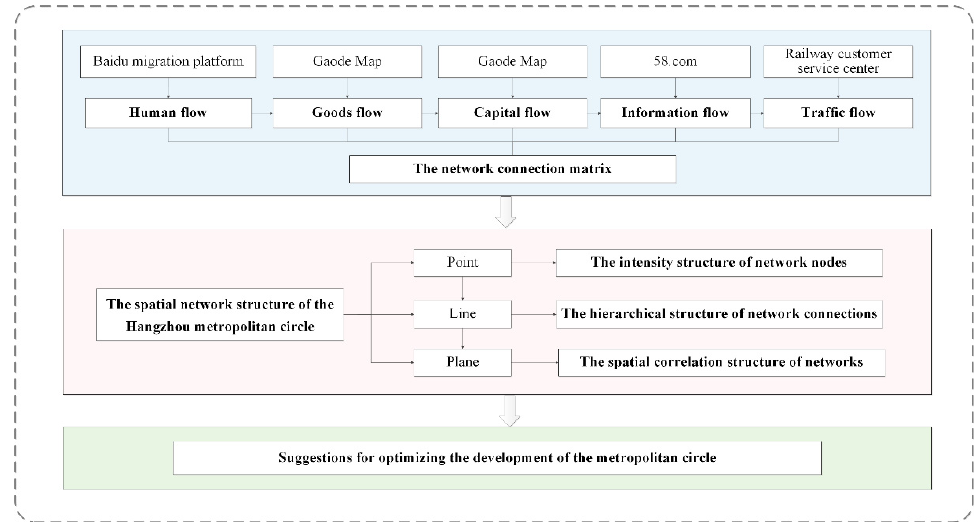
Figure 4. The workflow for implementing the analytical framework.